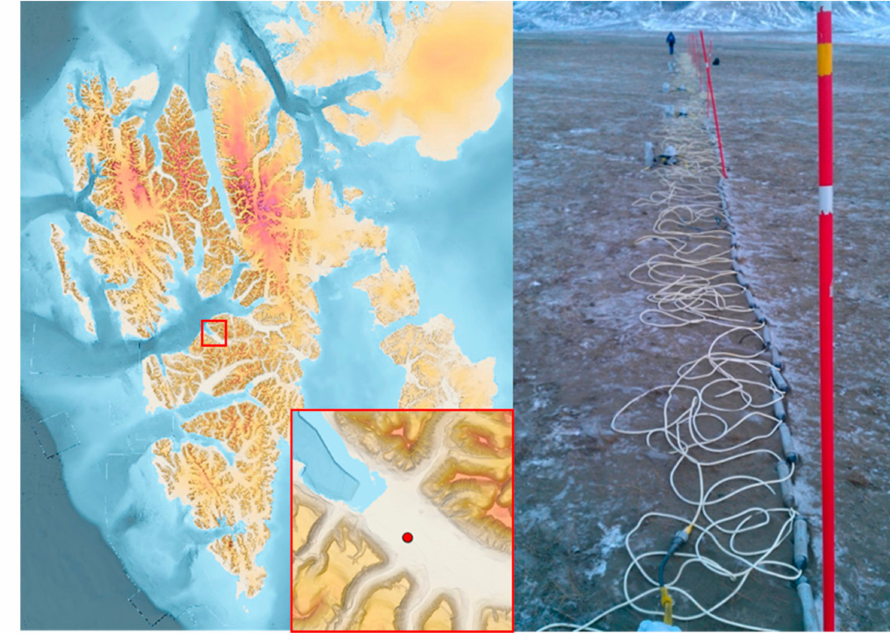
Figure 6. The location of the real seismic experiments in Adventdalen on Svalbard in the Norwegian Arctic is marked with a red dot in the small topographic map. The picture shows the study site in October 2013. Gimballed geophone strings are laid out with a 2.5 m group interval. Maps courtesy of Norwegian Polar